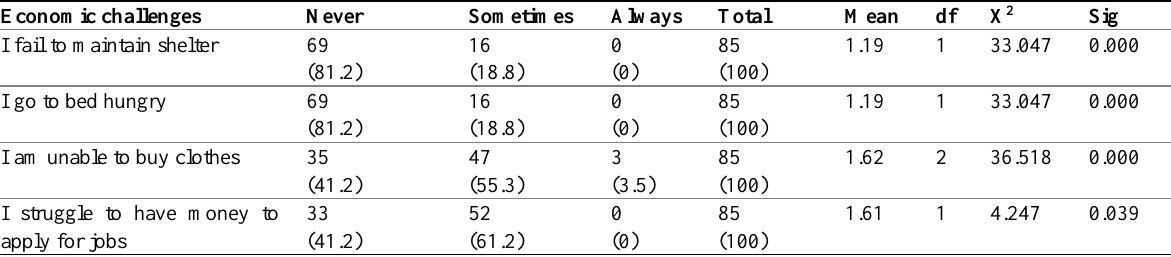
Table 5: Economic challenges faced by the unemployed